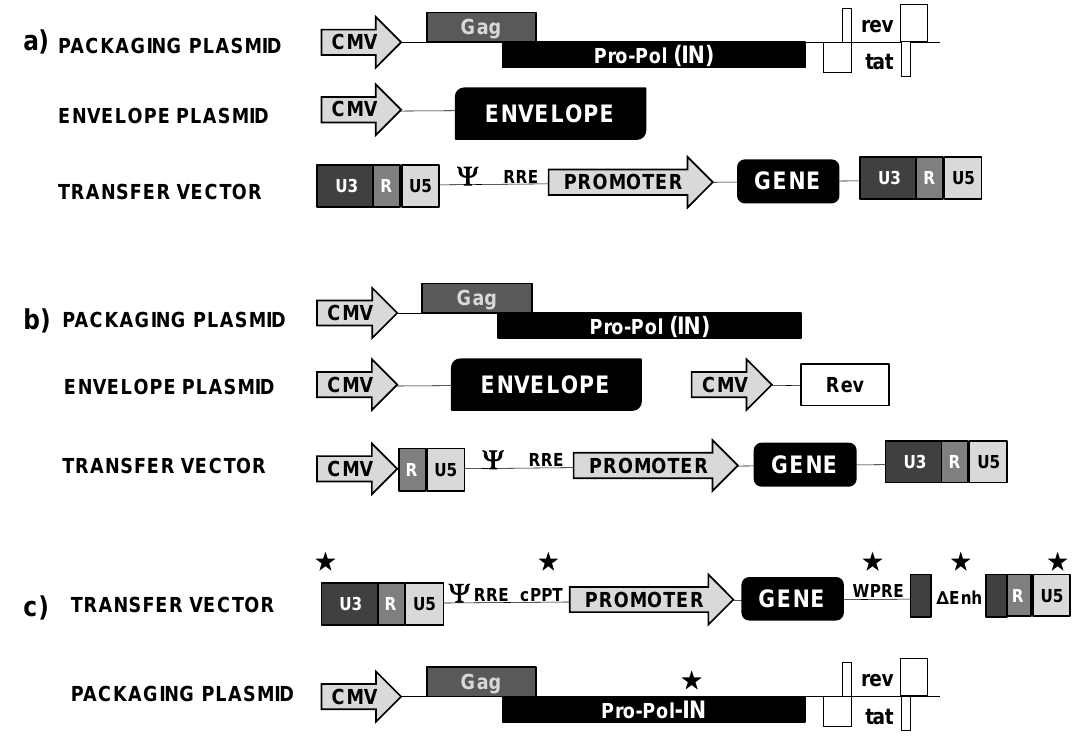
Figure 3. Engineering of lentivector systems and improvements in performance and biosafety. ( A ) The second generation lentivector system consists of the three plasmids schematically shown in the figure. The packaging and the envelope plasmids contain a strong constitutive promoter such as cytomegalovirus promoter (CMV), which controls the expression of structural/enzymatic HIV-1 proteins required for lentivector assembly and reverse transcription/integration (structural plasmid), or expression of the envelope glycoprotein VSV-G for vector pseudotyping (envelope plasmid). The transfer vector plasmid encodes a defective HIV-genome, lacking all the genes provided by the packaging plasmid. In this figure the transfer vector contains the two long-terminal repeats (U3-R-U5) and an expression cassette. This cassette is made of an internal promoter of choice controlling the expression of the gene of interest. The packaging signal is represented as  and the rev response element as RRE. Of note, this system is rev and tat-dependent (see packaging plasmid). ( B ) The third generation lentivector system is schematically depicted. This is similar to the second generation system but the rev and tat genes have been removed from the packaging plasmid. Thus, in this system, the transfer genome is controlled under the transcriptional activity of a strong constitutive promoter such as cytomegalovirus promoter (CMV) by the replacement of the 5' HIV U3 region. ( C ) Further improvements on lentivector biosafety and performance are schematically highlighted in this figure by stars. These include the addition of the central polypurine flap (cPPT), the woodchuck post-transcriptional regulatory element (WPRE), and the removal of enhancers from the 3' HIV U3, generating self-inactivating lentivectors (ΔEnh). Nonintegrating lentivectors can also be engineered by for example introducing point mutations and deletions within the integrase attachment sites in the 5' U3 region of the transfer vector plasmid, or in the integrase itself, to render it non-functional. Non-integrating lentivectors remain in the nucleus as